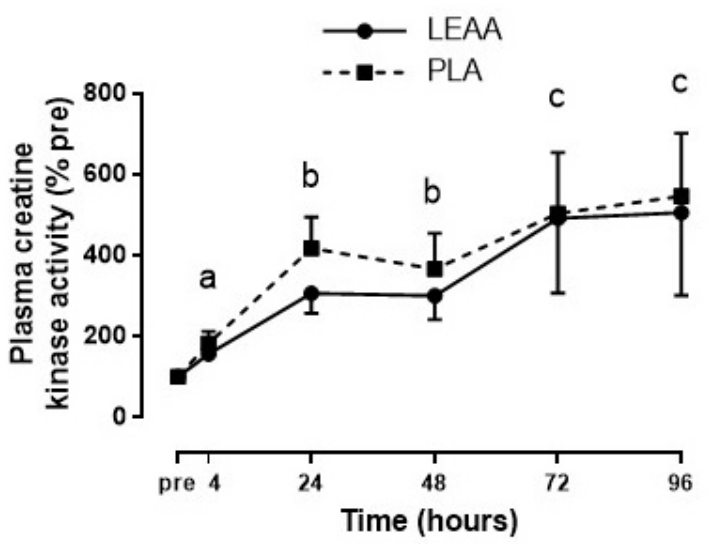
Figure 6. Mean ( ± SEM) plasma creatine kinase activity over 96 h after resistance exercise in response to LEAA or placebo consumption. Time points with different letters are significantly different from each other (main effect for time, p < 0.05). Pre, pre‐exercise; PLA, placebo.